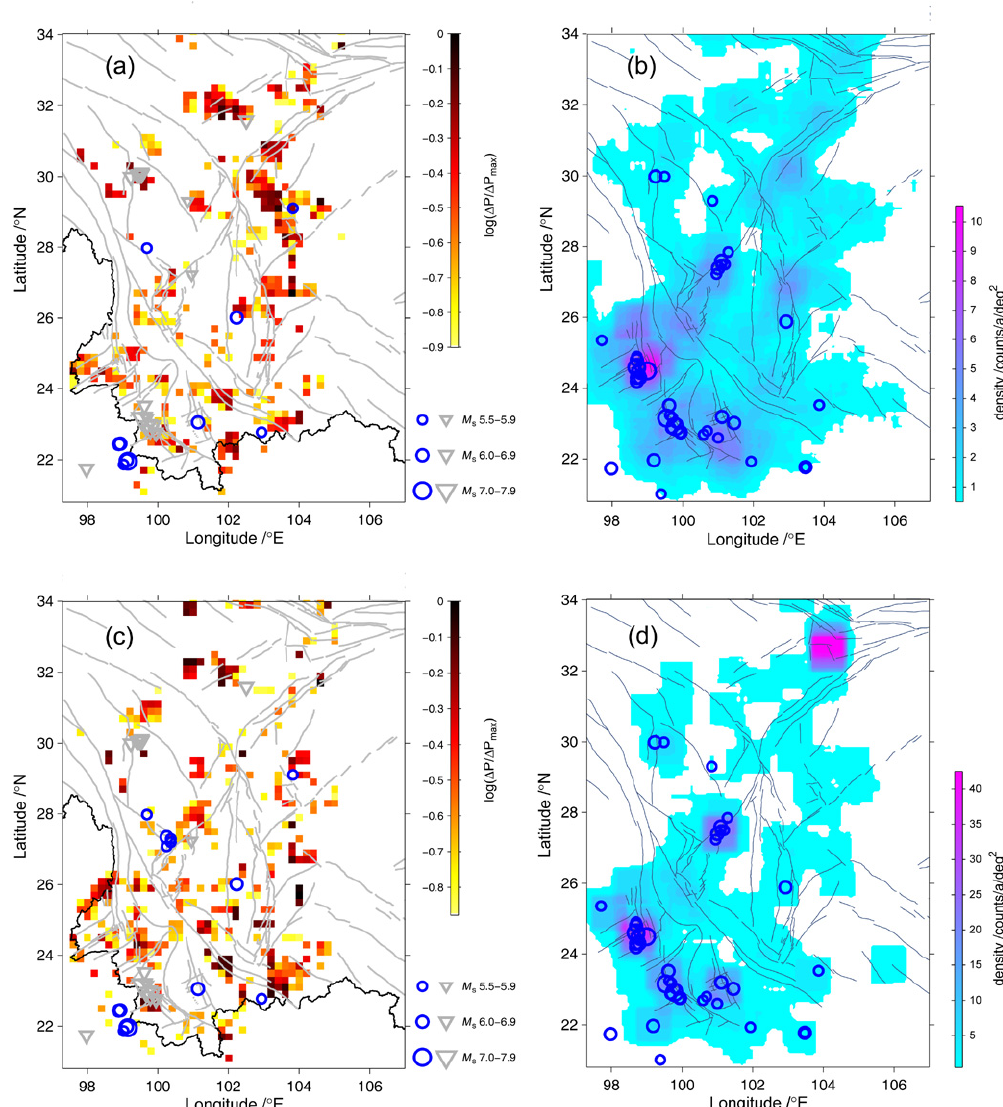
Fig. 8. Hotspot maps of the PI algorithm using “background” events. (a) Hotspot map with t 2 =1 January 1991. Color-coded hotspots highlight the relative probability increase for earthquakes above M S 5.5, with spatial grid size 0.2 ◦ . Blue circles stand for the earthquakes above M S 5.5 occurring within the “forecast window”, while gray reverse triangles show the earthquakes above M S 5.5 occurring within the “anomaly training window”. (b) Background seismicity rate for events in the sliding window used in Fig. 8a, shown by background seismic activity ˆ µ(x,y) . Blue circles show the earthquakes above M S 5.5. (c) Hotspot map with t 2 =1 January 1992. (d) Background seismicity rate for events used in Fig.